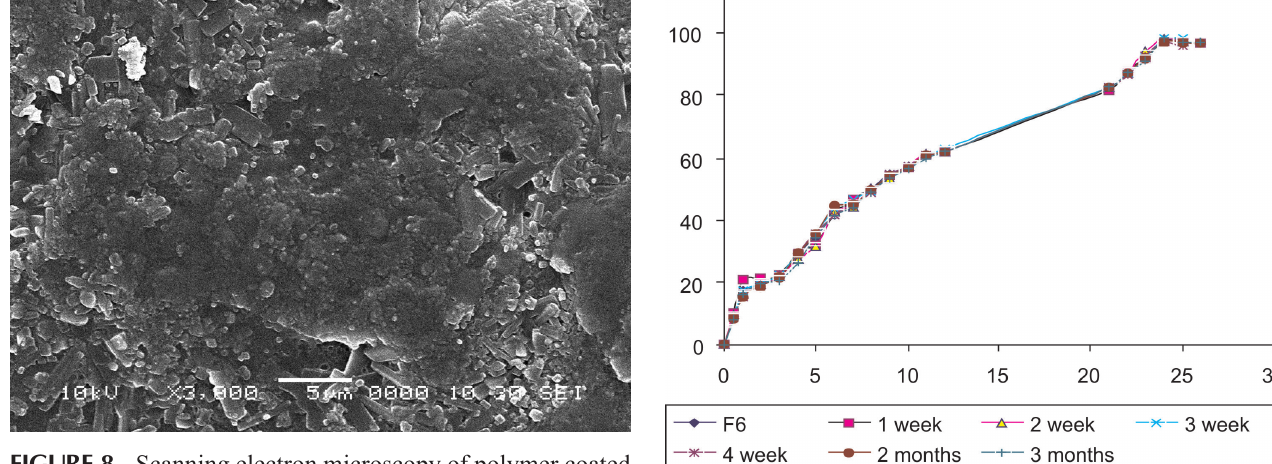
FIGURE 8 - Scanning electron microscopy of polymer coated pellets of an optimized batch F6 (X3000).